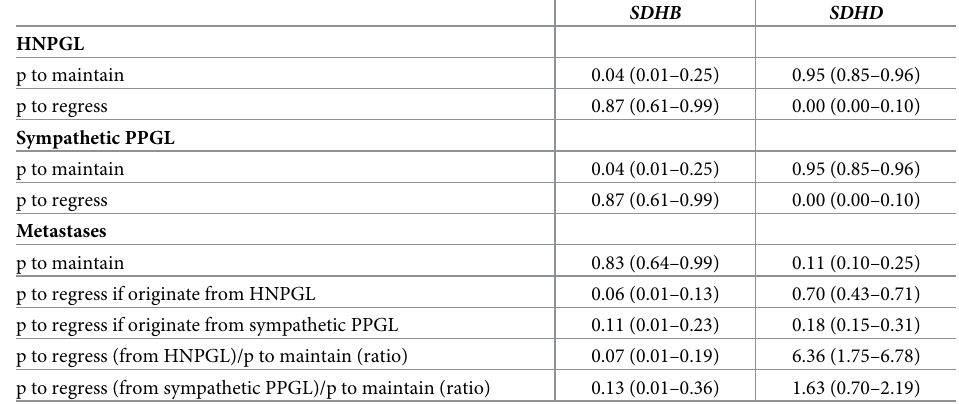
Table 2. Differences in estimated transition probabilities into the different clinically-defined steady states in SDHB and SDHD -related